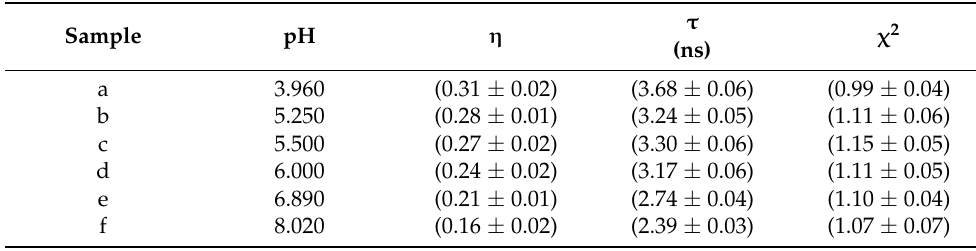
Figure 5. Fluorescence quantum efficiency ( η ) and absolute nonradiative quantum efficiency ( ϕ ) for natural dye that was extracted as a function of pH at 514.5 nm. Table 2. η , τ , and χ 2 values for aqueous natural dye that was extracted from Tradescantia leaves as a function of pH